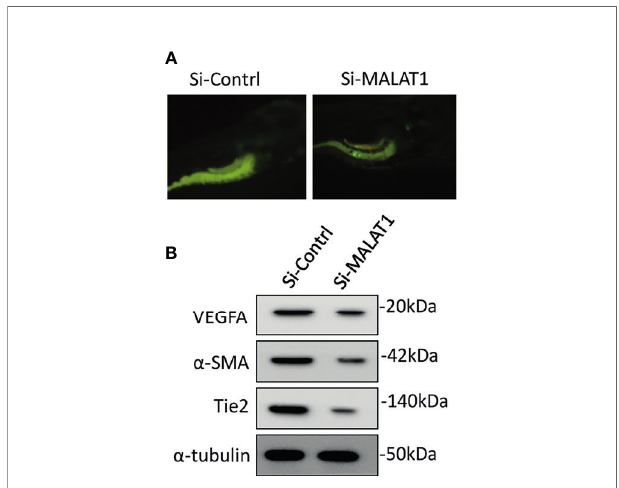
FIGURE 6 | Knockdown of MALAT1 suppressed OS-induced angiogenesis in zebra fi sh xenograft model. (A) CellTracker ™ Green CMFDA-labeled MG63 cells were injected into 2 days of postfertilization, which were screened after 24 h (B) After 24 h of cell injection, a whole lysate was collected from the embryo and subjected to Western blot analysis using the antibodies indicated. As an internal loading control, a -tubulin was used.